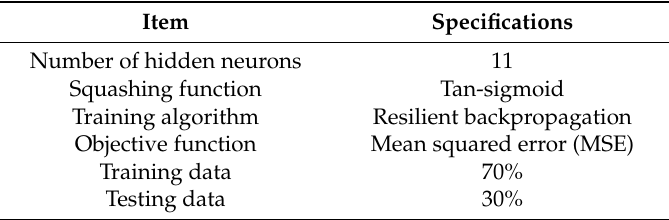
Table 10. Multilayer perceptron neural networks (MLP-NN) parameters for the faulty section identification